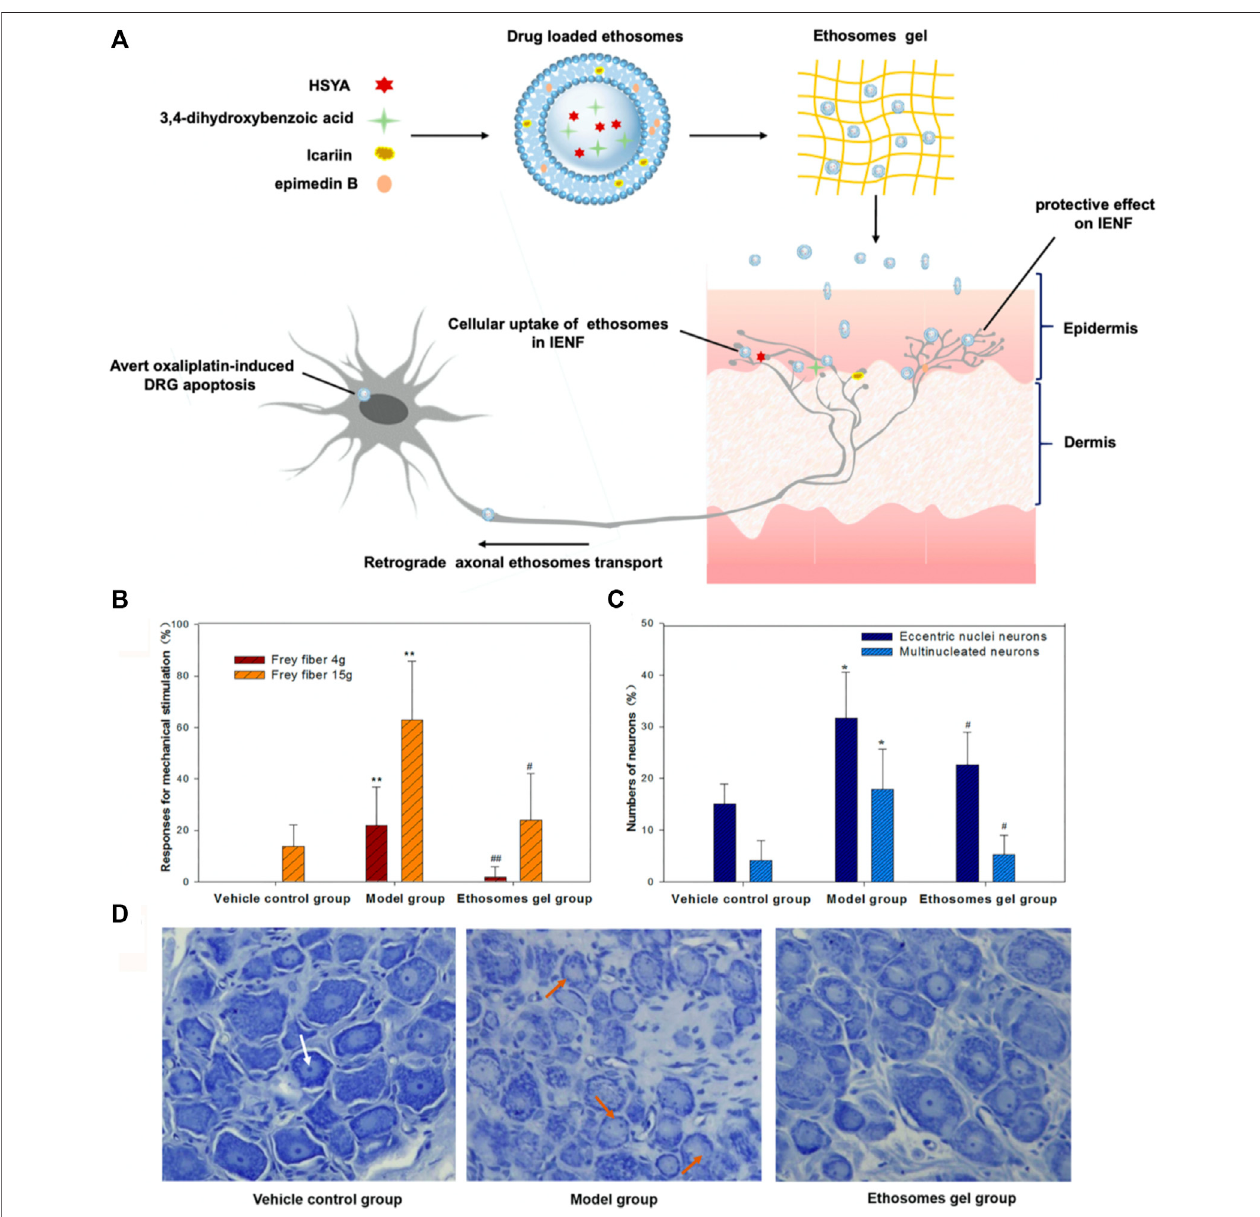
FIGURE 3 | The four compounds-loaded ethosome gels for PIPN treatment. (A) Schematic illustration of the ethosome gels. (B – D) The neuroprotective effect on rat invivo .Behaviorresponse tomechanicalstimulation (B) ,thenumbersofeccentricnucleiandmultinucleatedneurons (C) ,themorphologyofDRGneurons (D) ;white arrow, normal nucleoli; orange arrows, eccentric nuclei and multinucleated neurons in different